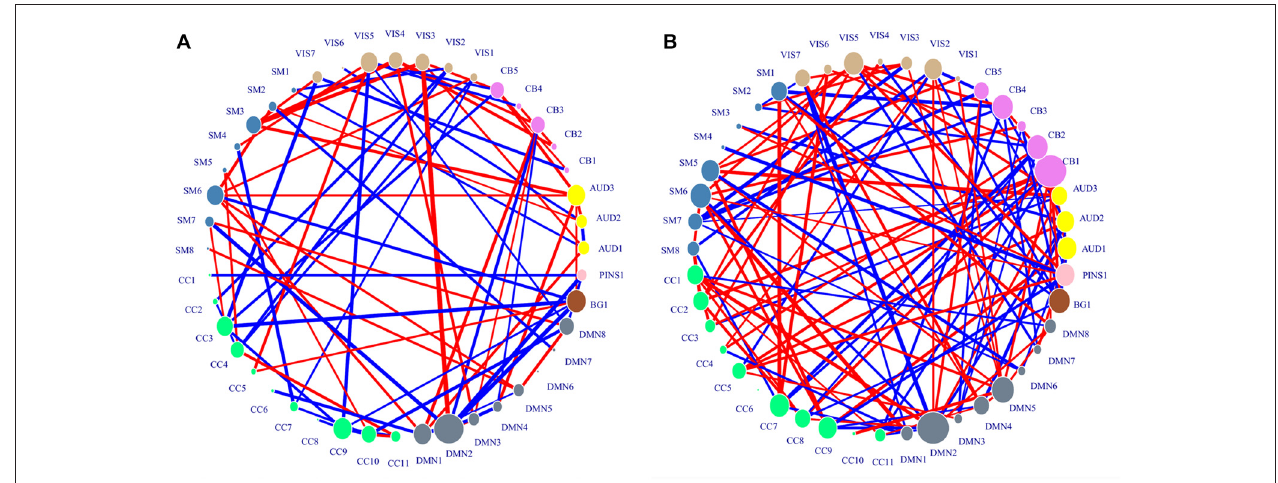
FIGURE 3 | Distribution of consensus connections. Nodes were colored by ICN, and their sizes were weighted by activation values. The red lines indicate the decreased trend of value in generalized anxiety disorder (GAD) adolescents, and the blue lines indicate the increased trend of value in GAD adolescents. The widths of lines are weighted by their standard activation values. (A) Region activation values and consensus connections of H features. (B) Region activation values and consensus connections of variance